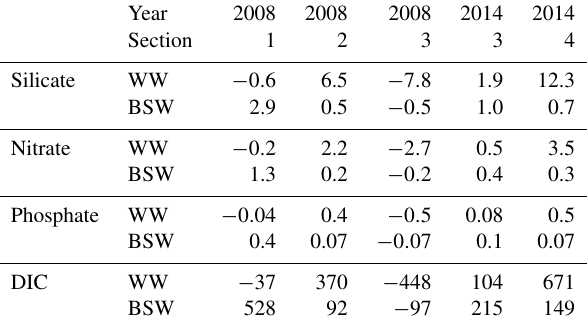
al., 1963), they correspond to a shift in phosphate of 0.19 and Table 3. Transport of nutrients and DIC on a daily basis based on the measured data for the different sections; units are in 10 8 mold − 1 . Volume transport is the total from Table